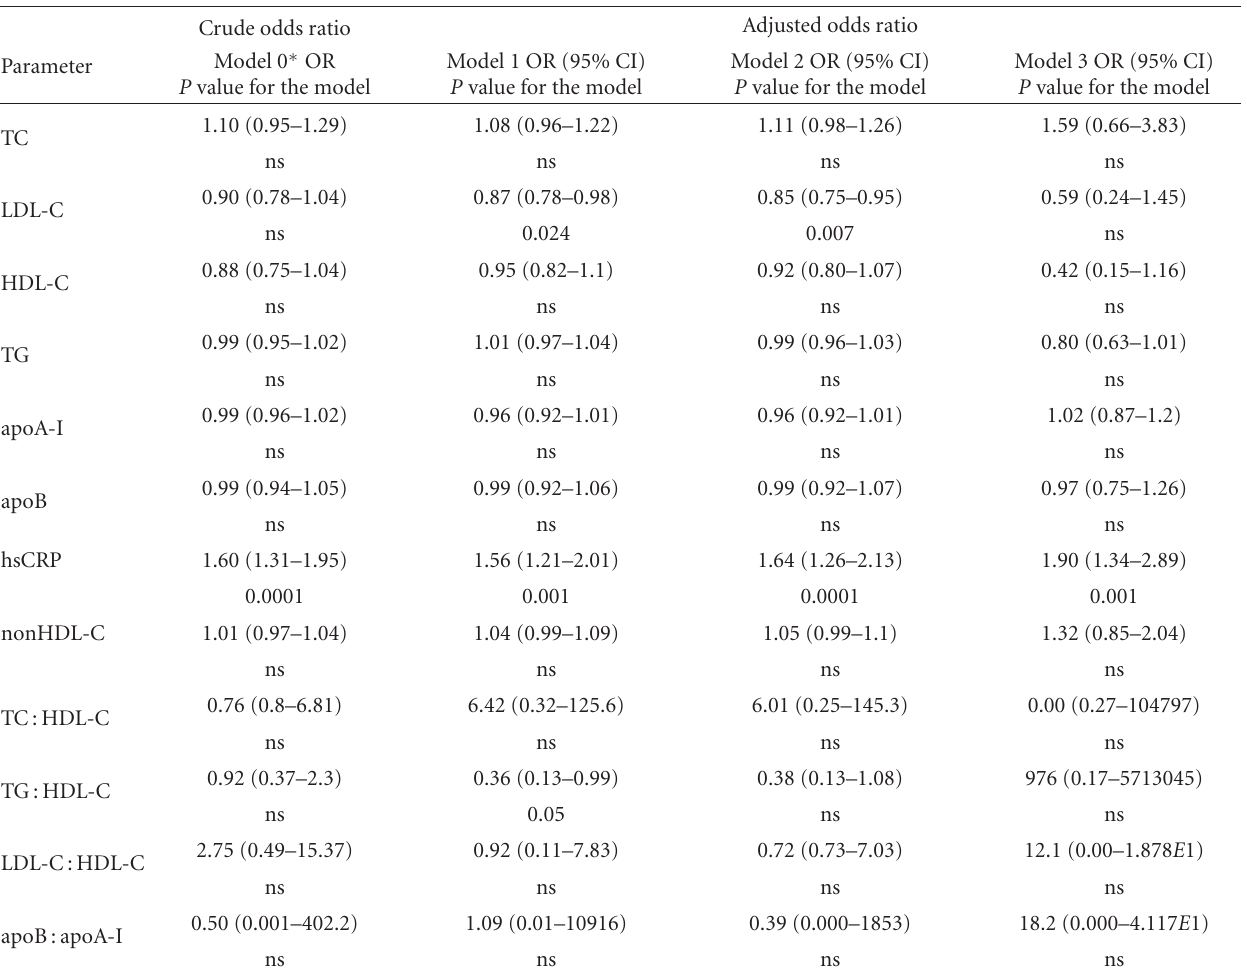
Table 5: The risk of the acute coronary syndrome for primary and secondary variables.